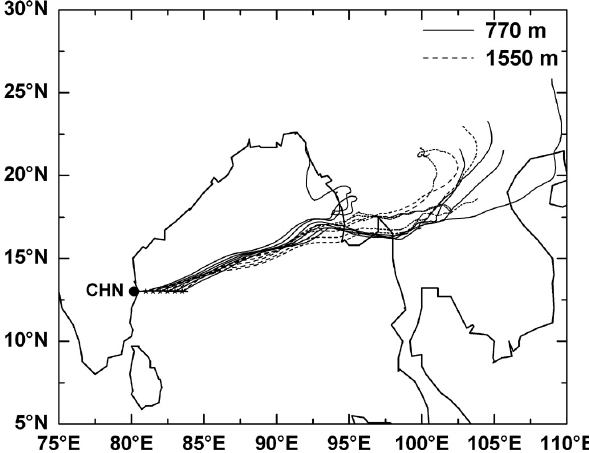
Fig. 9. Same as Fig. 7, but during BL6.